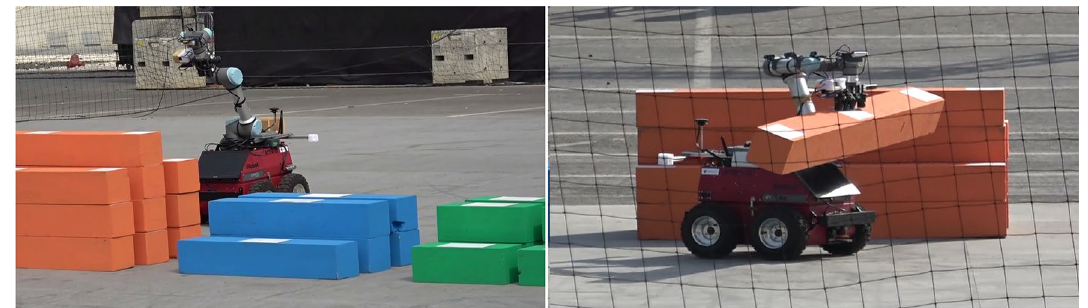
Fig. 1 Snapshot from the MBZIRC 2020 competition trial with the goal of constructing a wall composed of heterogeneous bricks, illustrating the bricks and the proposed mobile manipulator